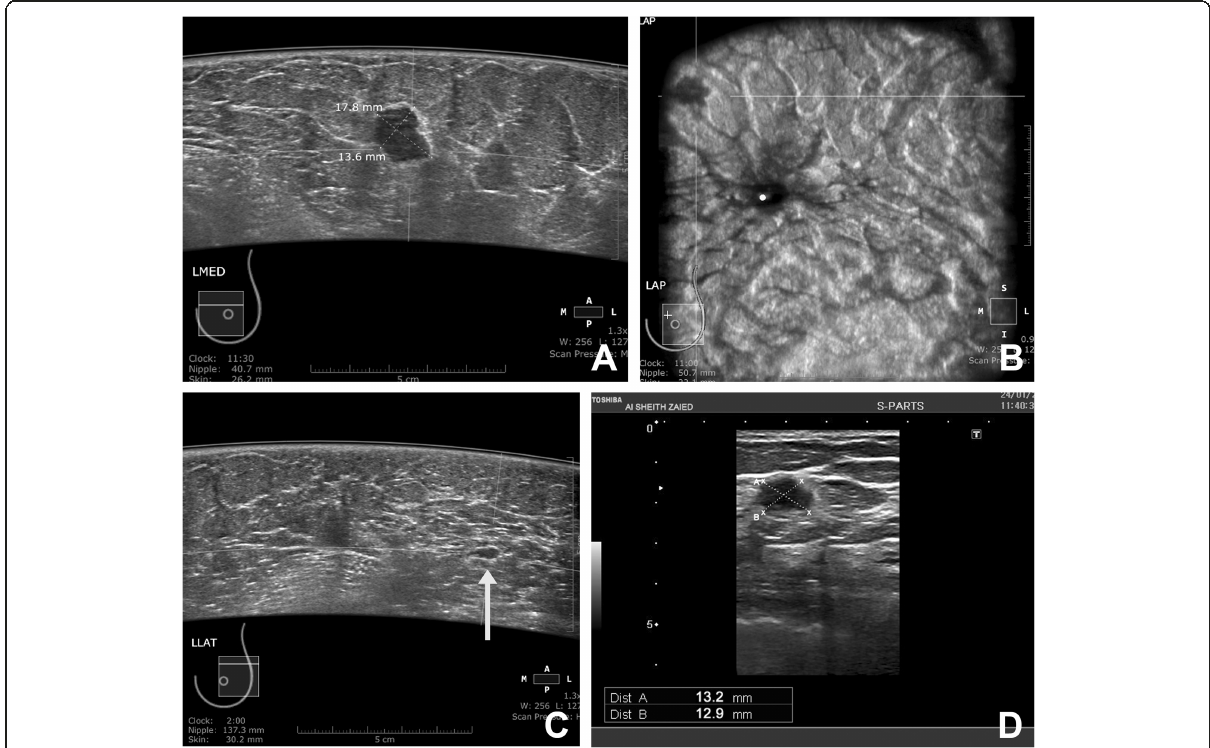
Fig. 1 Female patient 26 years old with histopathological diagnosis of an invasive ductal carcinoma type II. a , b Axial and coronal reformatted ABUS images shows a well-defined hypoechoic mass showing irregular outline in the left breast at its upper inner quadrant. The lesion measured 13.6 × 17.8 mm. c Axial reformatted ABUS image showing another well-defined smaller hypoechoic lesion in the upper outer quadrant (arrow) of the left breast, which was not seen by conventional HHUS. The smaller lesion measured 3 × 4 mm. d Corresponding HHUS of the larger left breast mass lesion, the lesion is well-defined, hypoechoic, having lobulated outlines and measuring 13.2 × 12.9 mm. The lesion was graded as BIRADS